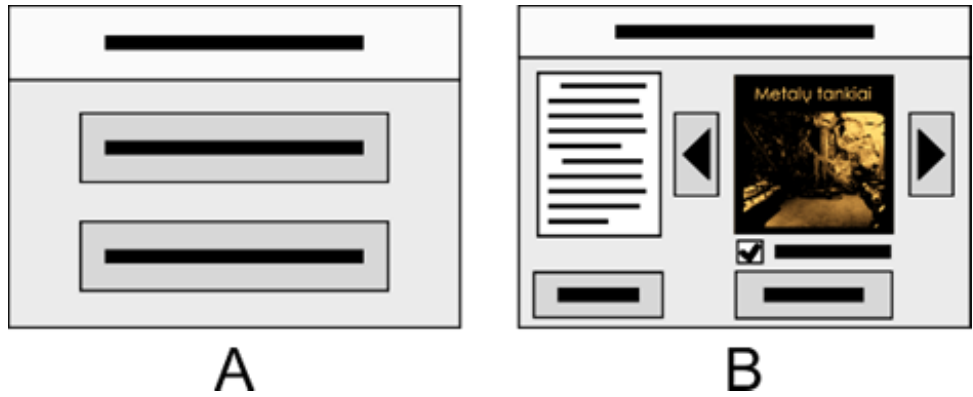
Figure 3. Layouts of the main menu ( A ) and script selection menu windows ( B ). The main menu contains the Start and Close buttons. In the scenario selection menu window, general information about the scenario is provided and the optional scenario can be set with the buttons